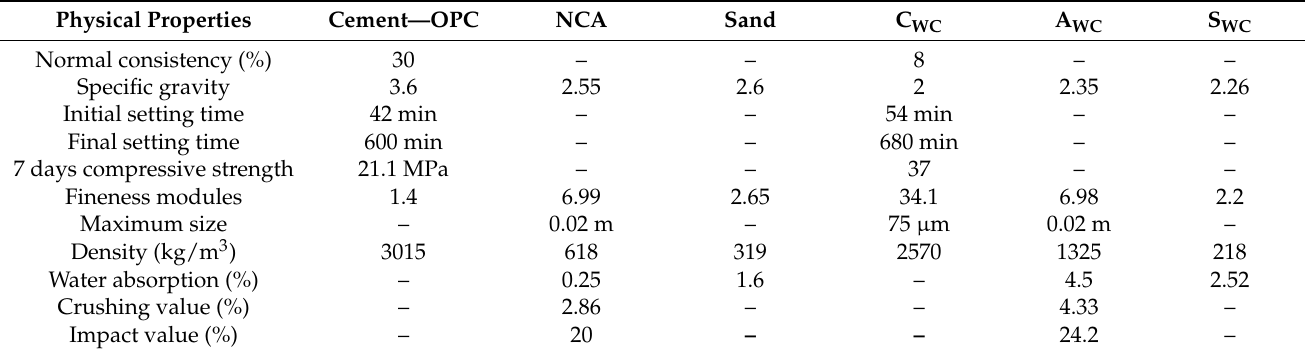
Table 1. Properties of Used